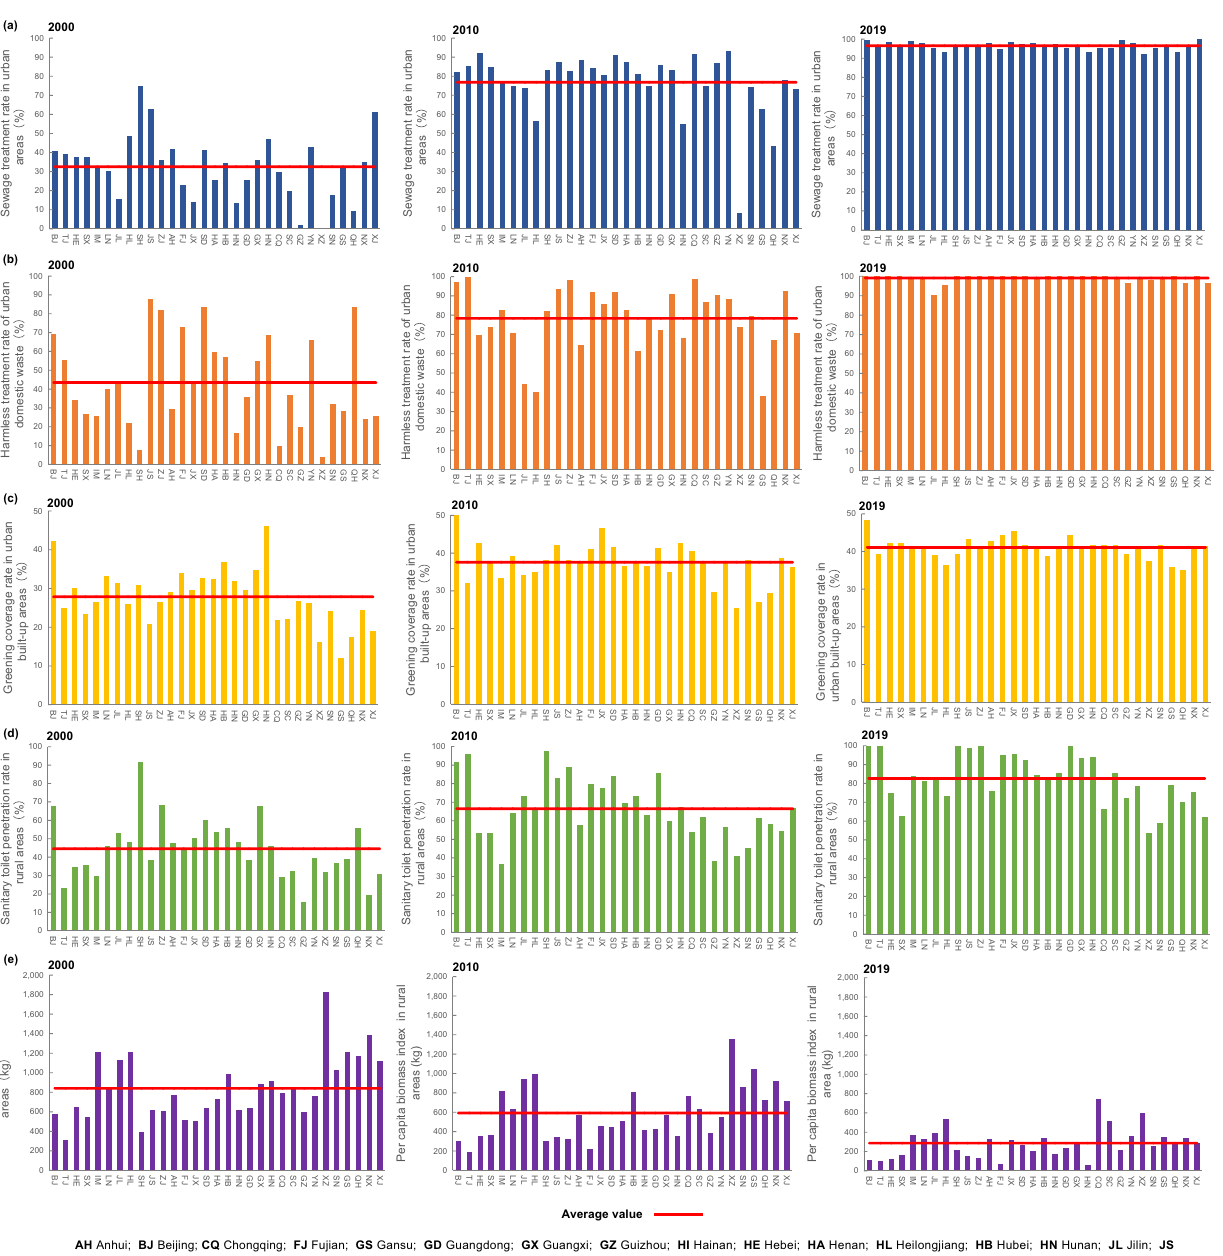
Fig. 3 Spatial distribution of each indicator of human settlements among 31 regions in 2000, 2010, and 2019. a – e Displayed the fi ve indicators. a Sewage treatment rate in urban areas. b Harmless treatment rate of urban domestic waste. c Greening coverage rate in urban built-up areas. d Sanitary toilet penetration in rural areas. e Per capita biomass index in rural